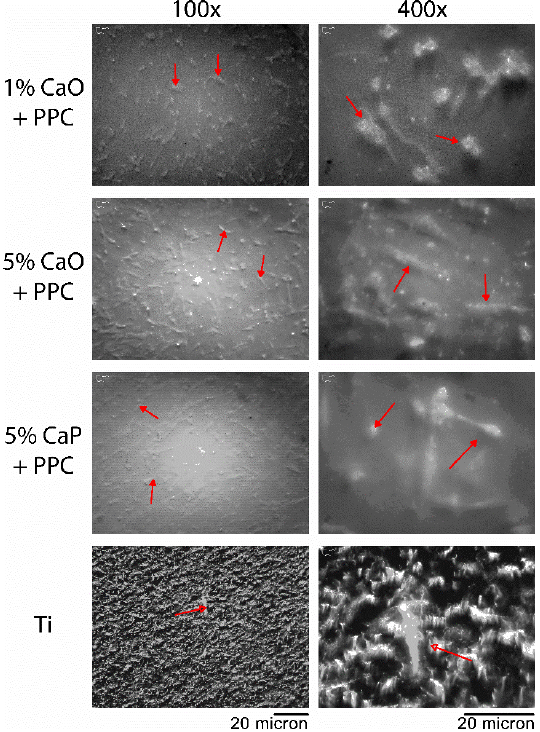
Figure 8. Scanning electron microscopy (SEM) of an attached cell culture. SEM illustrated a high cell confluency of the coated biomaterial and a spreading morphology where cells exhibited extended morphology, which consequently suggested an outstanding degree of the surface biocompatibility.